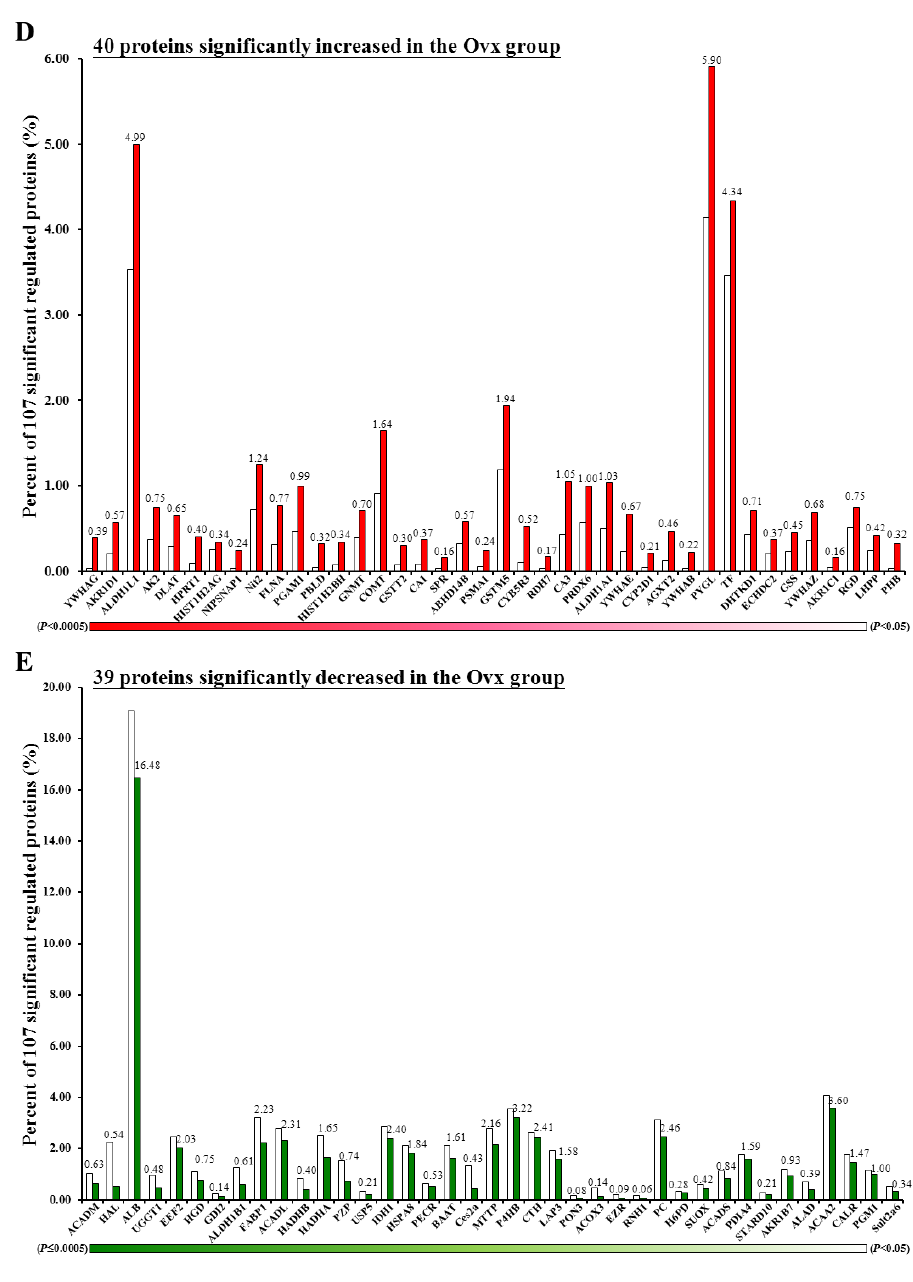
Figure 3. Venn diagrams comparing the common, only detected, or overlap of significantly regulated proteins in liver samples from Sham and Ovx rats. ( A ) Venn diagram of differentially expressed proteins; ( B ) Percentage distribution for the nine proteins detected only in the Sham group; ( C ) Percentage distribution for the 19 proteins detected only in the Ovx group; ( D ) Percentage distribution for the 40 proteins with significantly increased expression in the Ovx group compared to the Sham group; ( E ) Percentage distribution for the 39 proteins with significantly decreased expression in the Ovx group compared to the Sham group. The 88 and 98 identified proteins with differential expression for the Sham and Ovx groups, respectively, were mostly in cytoplasm (37/88, Ovx group; 45/98, sham group), mitochondria 8 (16/88, Ovx group; 16/98, sham group), and endoplasmic reticulum (8/88, Ovx group; 10/98, sham group) (Figure 4).